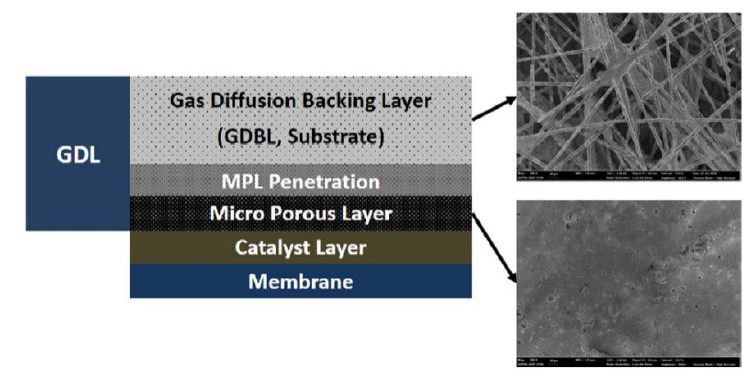
Figure 9. Schematic diagram of the GDL structure [92].